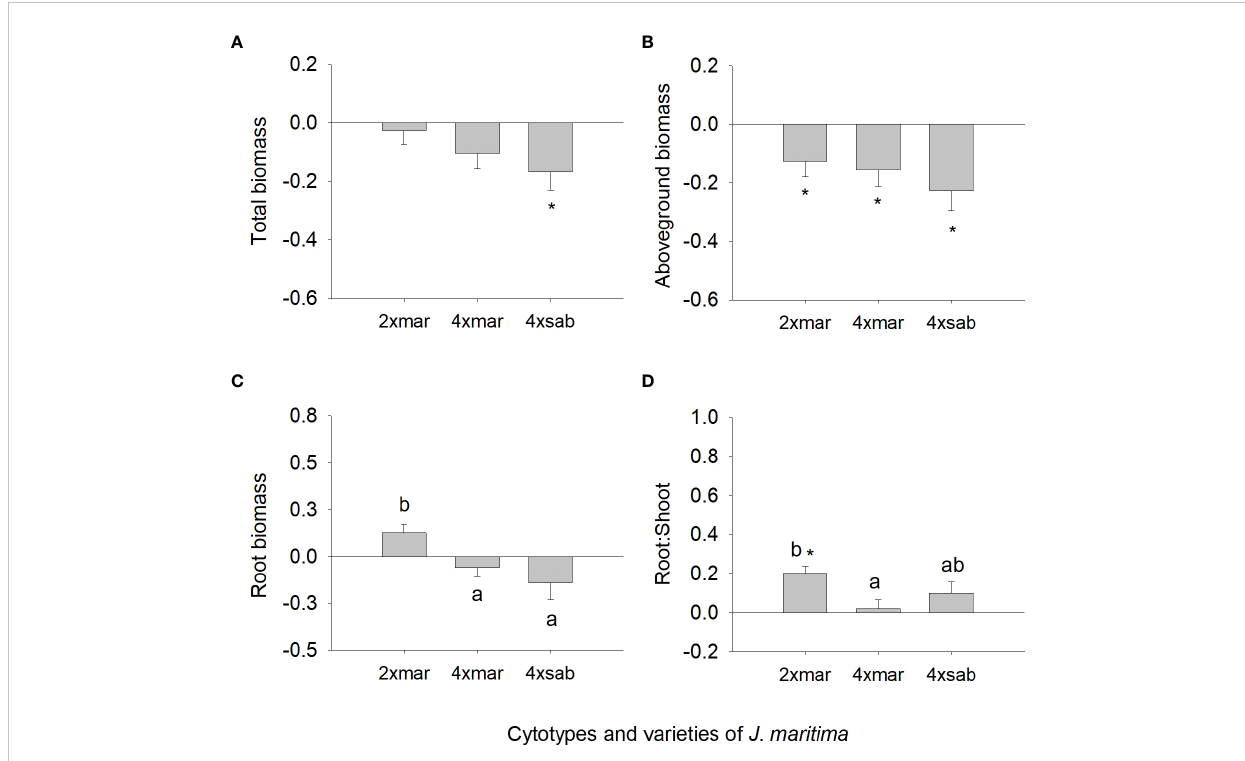
FIGURE 5 Response ratio (mean ± SE) for total biomass (A) , aboveground biomass (B) , root biomass (C) and root to shoot ratio (D) of populations of diploid and tetraploid Jasione maritima var maritima and tetraploid Jasione maritima var sabularia. Signi fi cant differences at P < 0.05 among cytotypes are indicated by different letters. The presence of * indicates that the response ratio differed signi fi cantly from